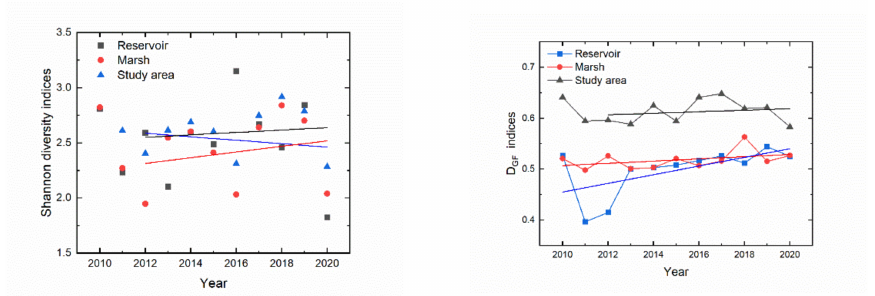
Figure 6. Annual variation of species diversity index of waterbirds in different habitats. Note: Study area denotes all data in the marsh and reservoir